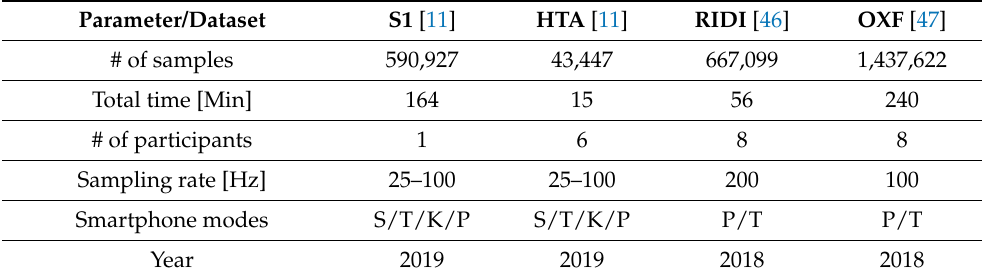
Table 2. Main parameters of all four datasets used in the training process. Smartphone locations are swing (S), texting (T), talking (K), and pocket